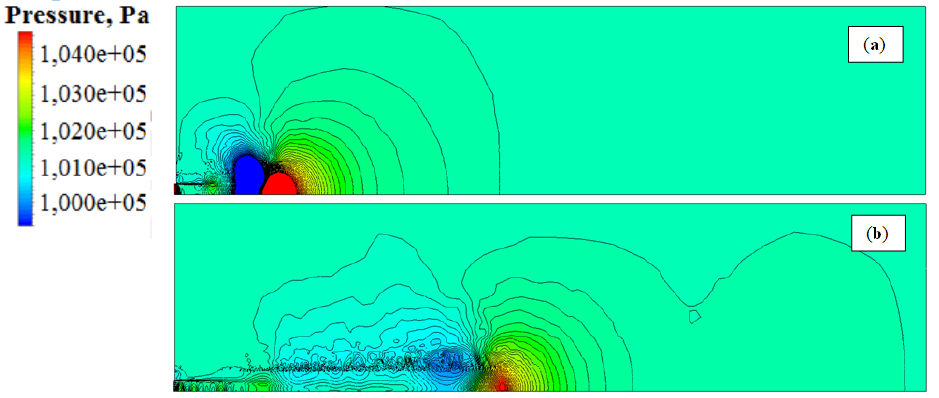
Figure 11. Calculation of the non ‐ stationary jet with Р 0 (0) = 0.70 MPa: ( a ) t = 0.01 s; ( b ) t = 0.02 s.